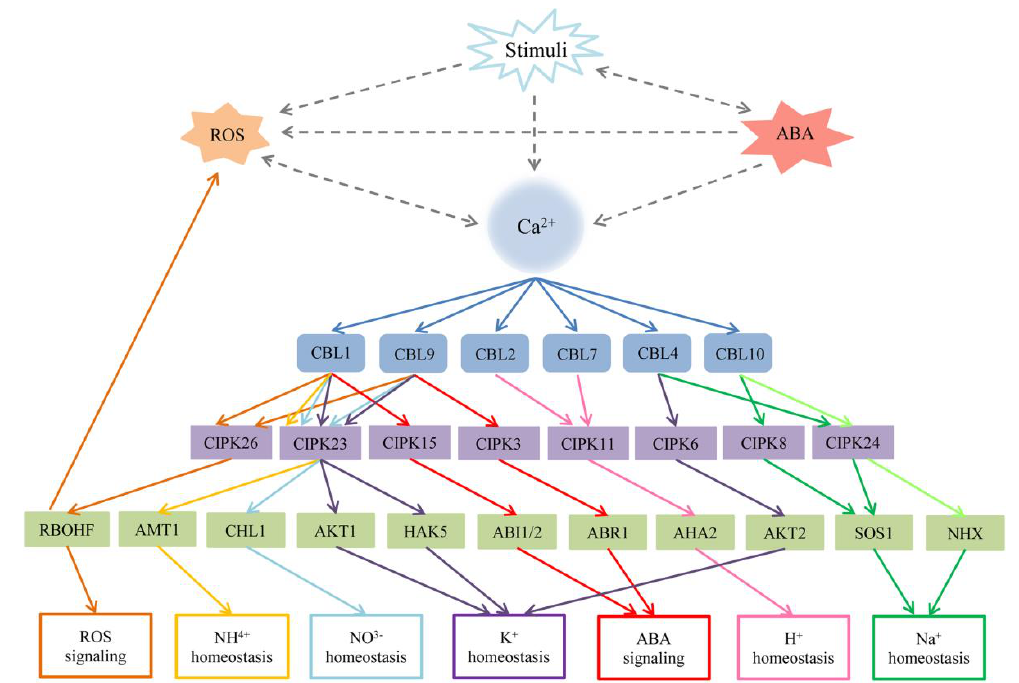
Figure 4. The relationship among Ca 2 + , the CBL–CIPK network, reactive oxygen species (ROS) signaling, abscisic acid (ABA) signaling, and other stresses in Arabidopsis . Stimuli usually increase the concentration of Ca 2 + , the production of ROS and ABA in the cytoplasm. Ca 2 + and ROS promote each other, and the accumulation of ABA will influence the concentration of Ca 2 + and K + . The dotted lines represent indirect connections. The solid lines represent di ff erent signaling. AtCBL1 or AtCBL9 interacts with multiple CIPKs to mediate di ff erent target proteins in the regulation of many progresses including K + , NO 3- , NH 4 + homeostasis, ROS, and ABA signaling. Other CBL–CIPK complexes regulate their related target to involve in H + and Na + homeostasis. ABI1 / 2: ABA insensitive 1 / 2; ABR1: Abscisic acid